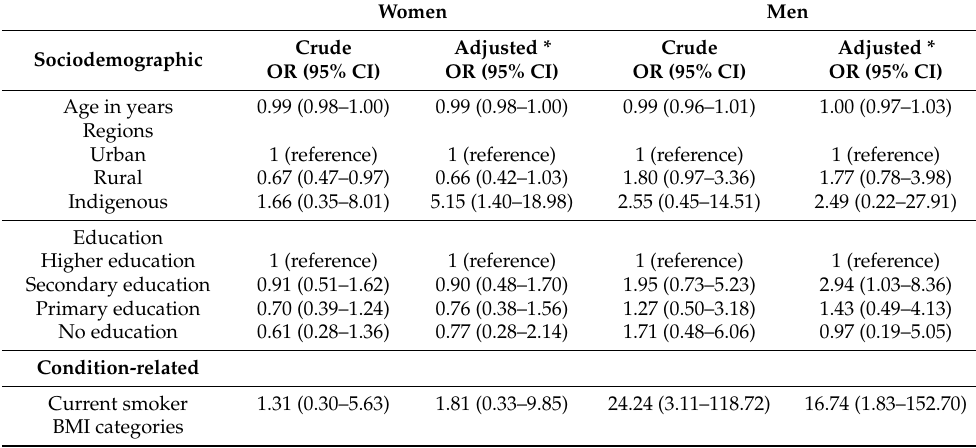
Table 4. Crude and adjusted logistic regression models for factors associated with low-moderate medication adherence in hypertensive participants aged 18 years old or more stratified by sex. ENSPA